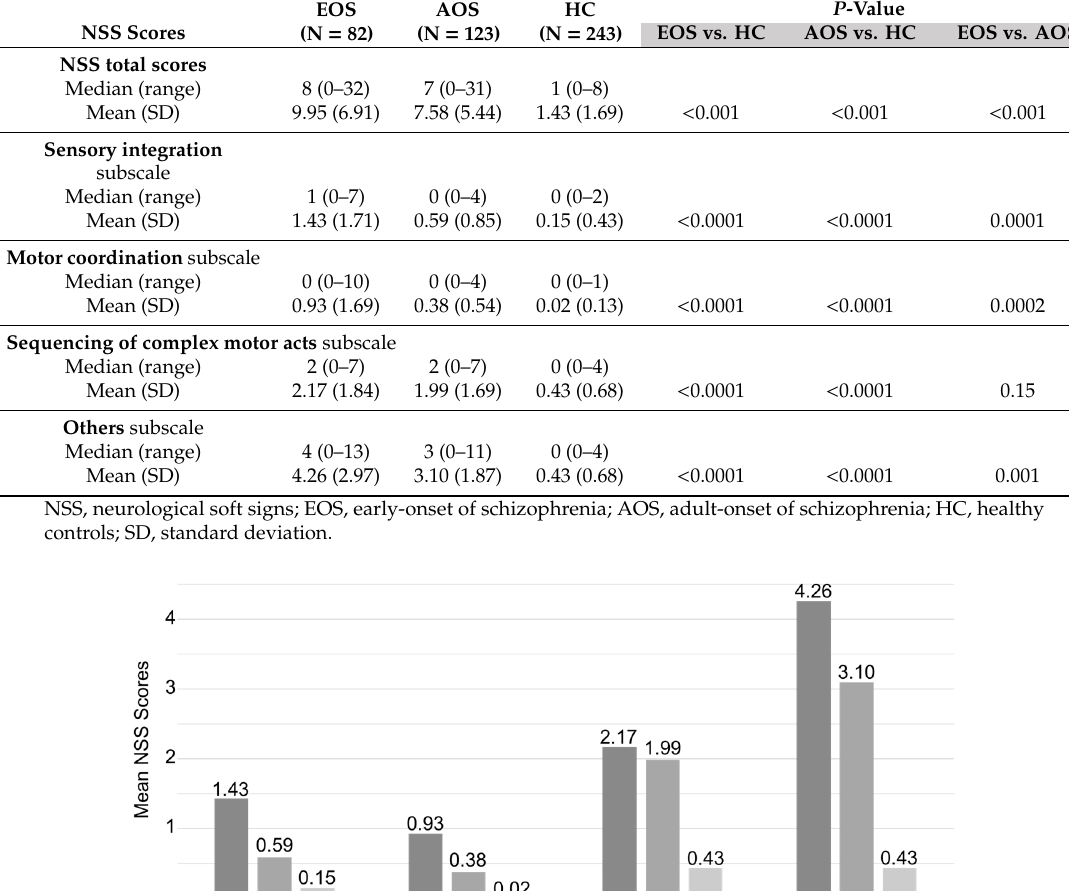
Table 2. Comparison of NSS scores for patients with early-onset and adult-onset schizophrenia versus healthy controls.